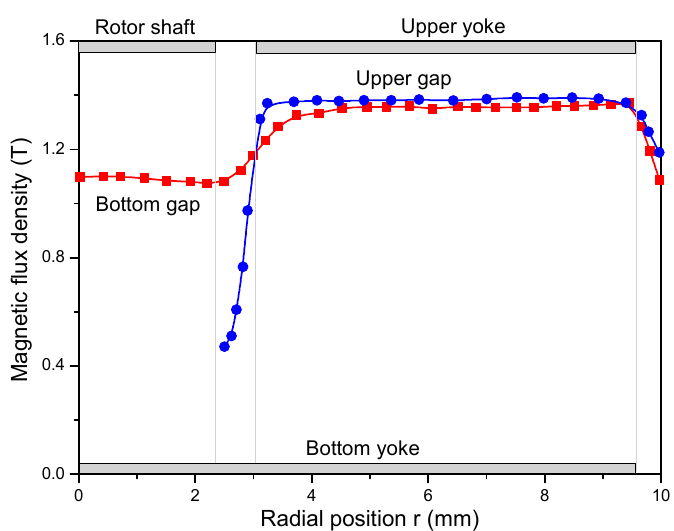
Figure 5. Simulated flux density profiles in the middle of the shear gaps filled by magnetorheological (MR) fluid at an input current of 3 A and gap of 1.1 mm [26].